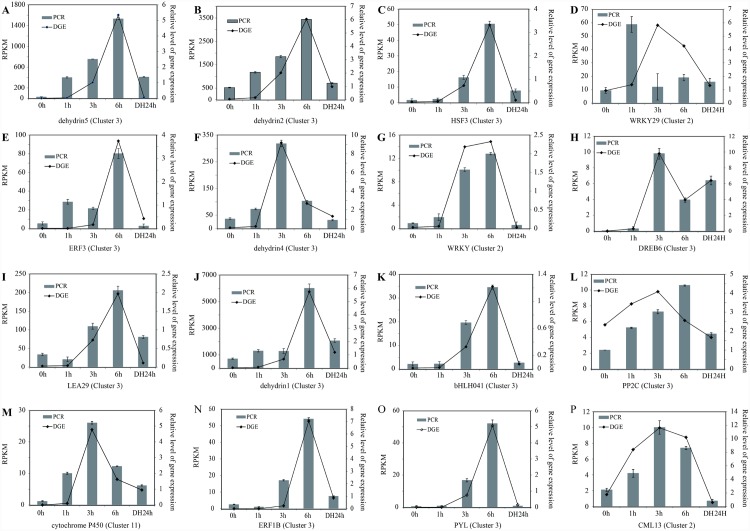
Quantitative RT-PCR validation of differential gene expression during dehydration.The left Y-axis indicates the gene expression levels calculated by the RPKM method. The right Y-axis indicates the relative gene expression levels.